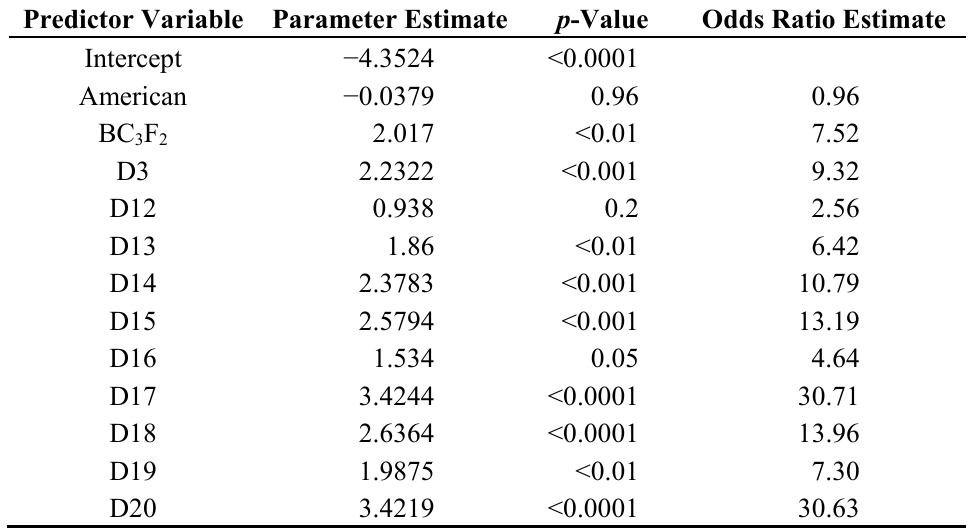
Table 6. Logistic regression model for probability of missing tap-roots using all data ( n = 1741), comparing all families to the Chinese